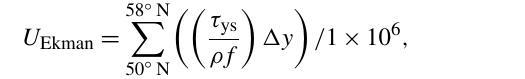
Figure 1. Quiver plot using ORCA12 data, indicating subsurface (245m) velocity magnitude and direction of the water, compar- ing winter (January) and summer (July) releases: (a) winter 1992; (b) winter 2010; (c) summer 1992; (d) summer 2010. Background colour highlights the magnitude of the v component of velocity, which is positive northwards. Green lines indicate the zonal tran- sects used for Fig.